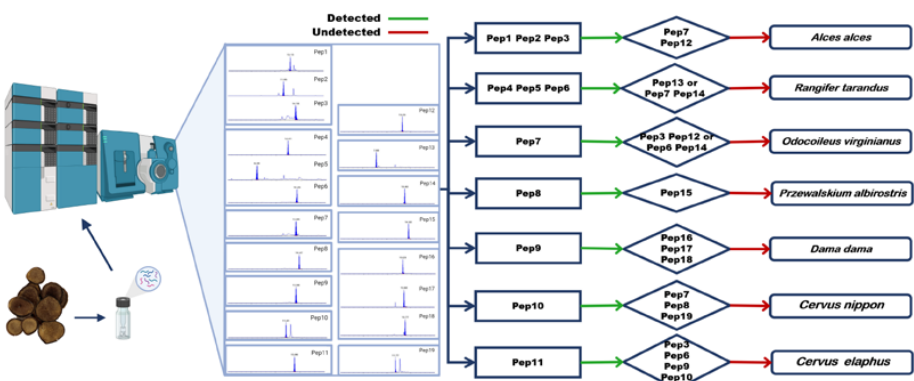
Figure 5. Strategy 2: Simultaneously identifying seven species of deer antler flakes and powder. The deer antler flakes and powder were processed by method 3.2 and then analyzed by HPLC-Triple Quadrupole MS. The peptide biomarkers in the rectangular box were used to preliminarily identify species, and peptide biomarkers in diamond box were used to further identification and checking for adulteration; red line means undetected, green line means